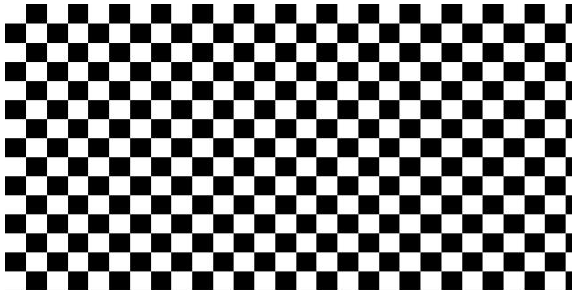
Figure 7. Some photographs suitable for Agisoft Photoscan software Table 1, is showing the mode of photography and image input format for these softwares. Table 1. Comparison of mode of photography and